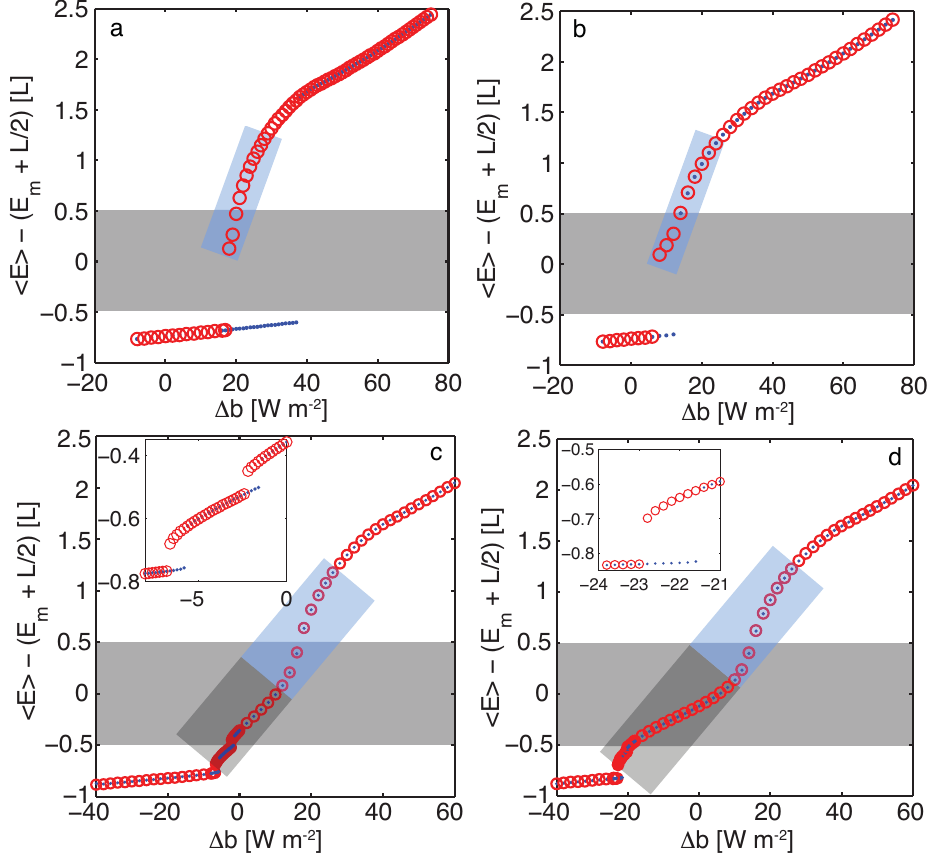
Fig. 9. Asymptotic states of the average cell energy h E i as a response to atmospheric forcing 1b for the albedo parameterizations in Fig. 3: (a) AST, (b) AQN, (c) AQW, and (d) ALW. Simulations with an initially ice covered state (blue dots) started with a uniformly frozen ice- ocean layer, and simulations with an initially open water state started from a uniform water layer as in Fig. 4b. The ice cover is seasonal for the data points within the blue shaded area, and surface melt exists for the data points within the dark grey shaded area. Convergence is reached within numerical accuracy, i.e., doubling the simulation time does not change the values of h E i .